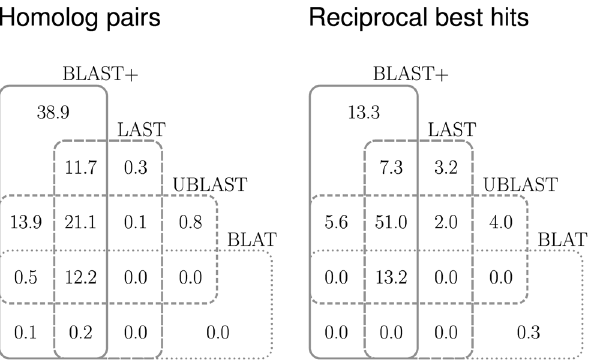
Figure 3. Matching pairs. Most homologous pairs found by LAST, UBLAST and BLAT were also found by BLAST. Differences in scoring resulted in a higher proportion of different RBHs found by either programs than would be expected from the sets of homologous